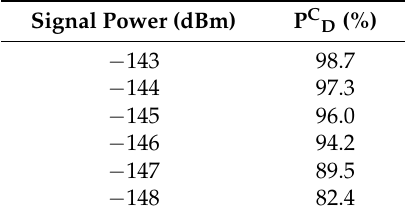
Table 3. Performance of BCNN decision policy.